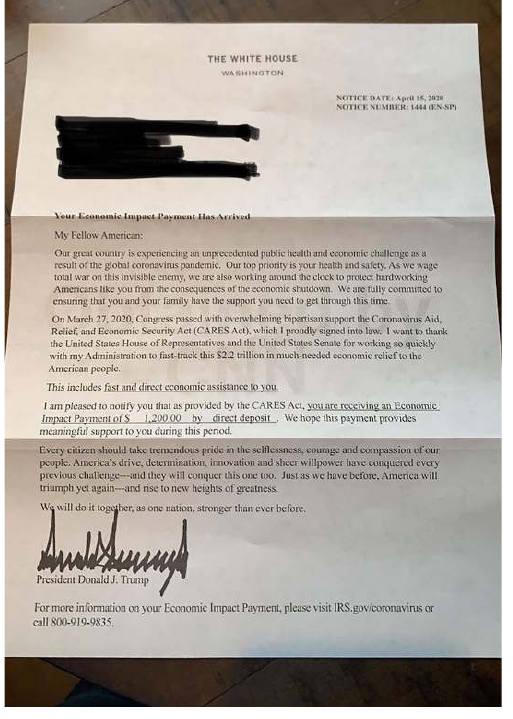
Figure 1: Letter by Donald Trump accompanying the April 2020 stimulus